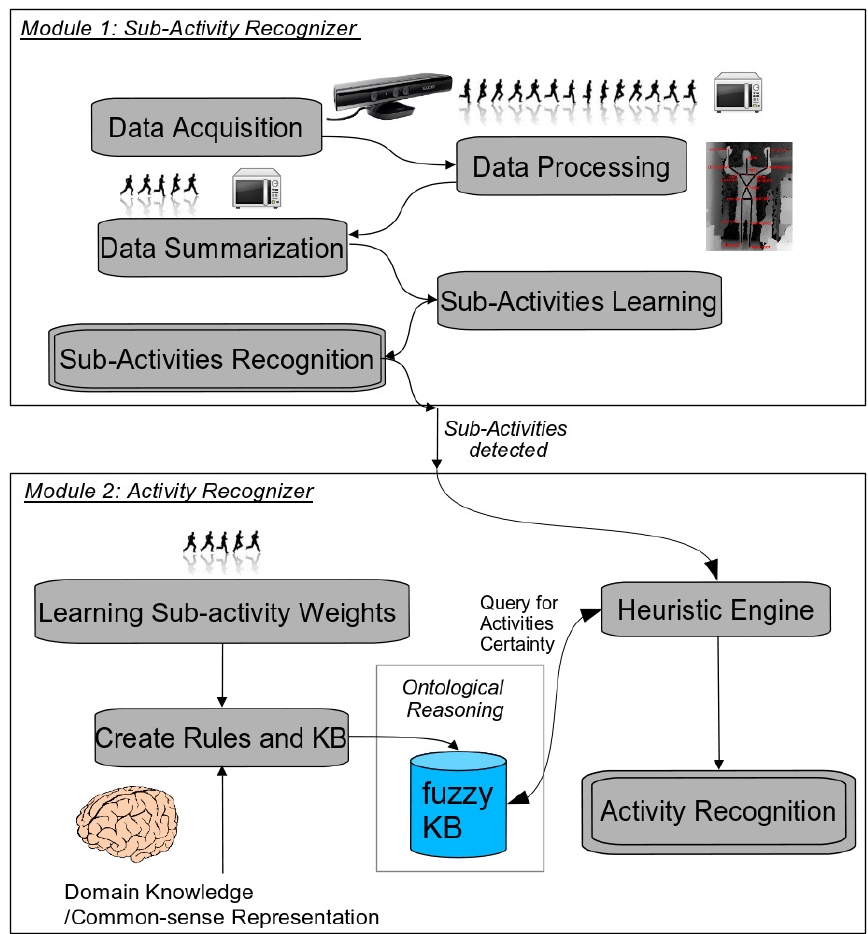
Figure 1. General diagram of the proposed hybrid